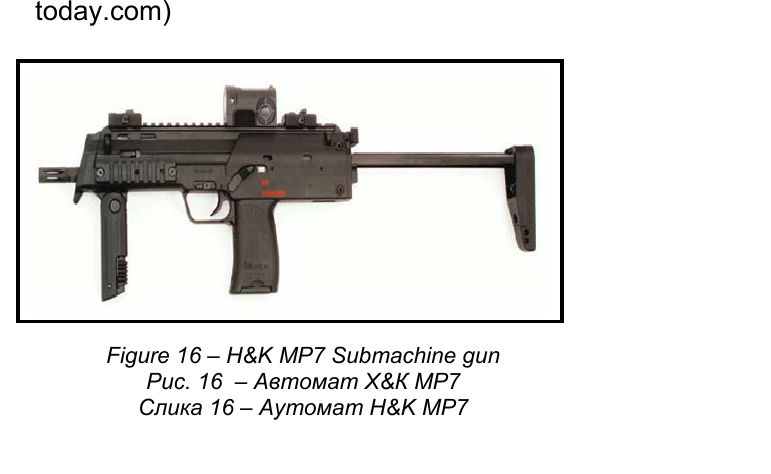
Figure 16 – H&K MP7 Submachine gun Рис . 16 – Автомат Х & К MP7 Слика 16 – Аутомат H&K